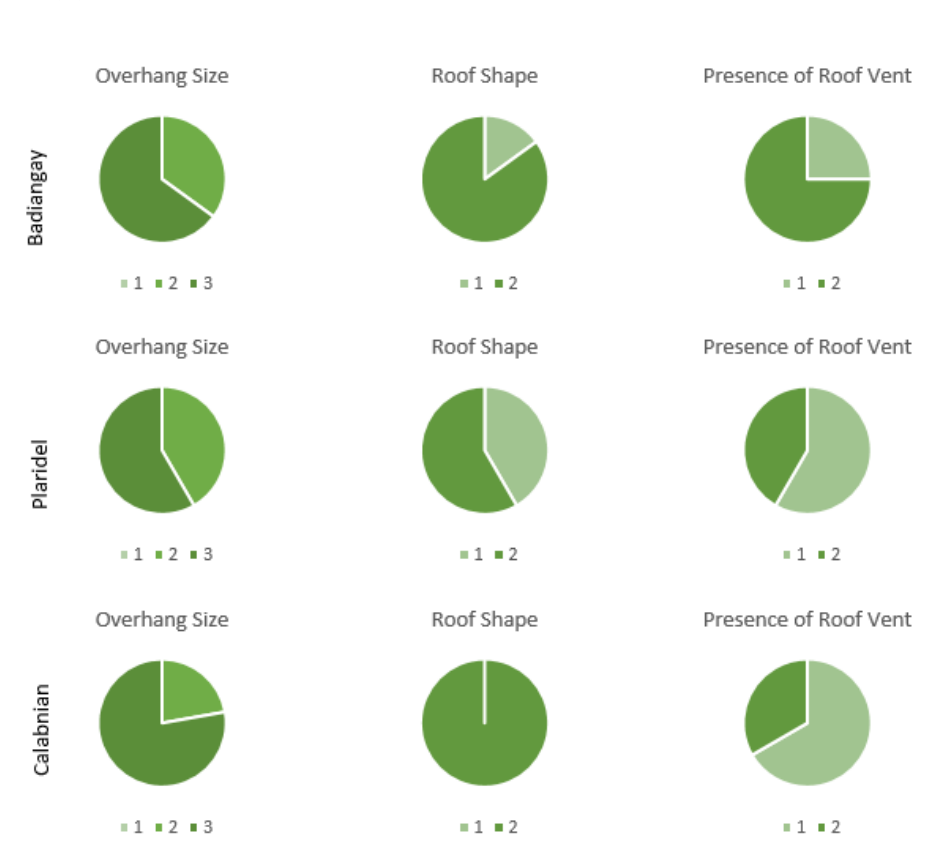
Figure 14. Vulnerability indicator distribution for wind hazard across three locations: Badiangay, Plaridel, and Calabnian.